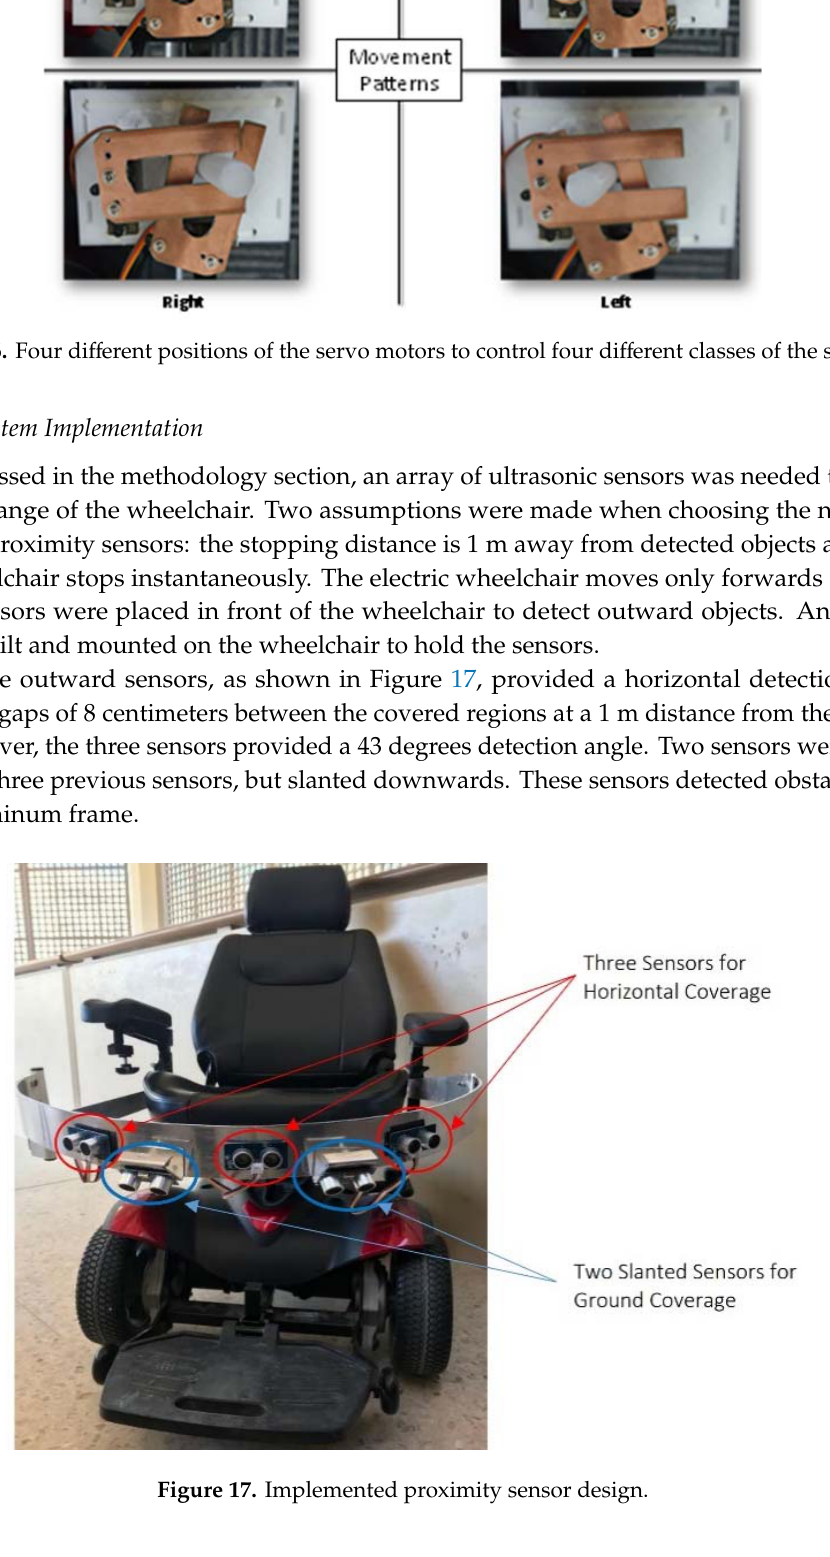
Figure 15. Two servo motors along with two moving arms were attached to original joystick with 3D printed support structure for motion control.